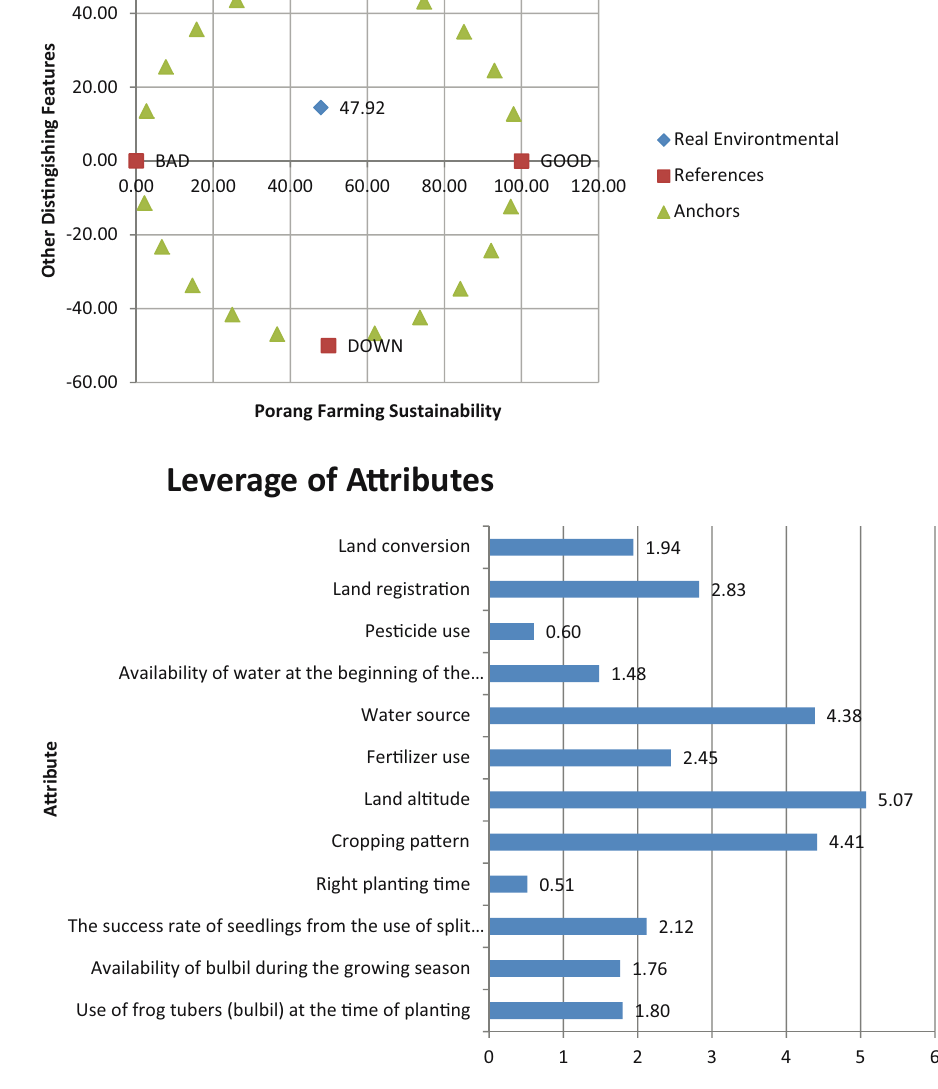
Figure 3: Environmental